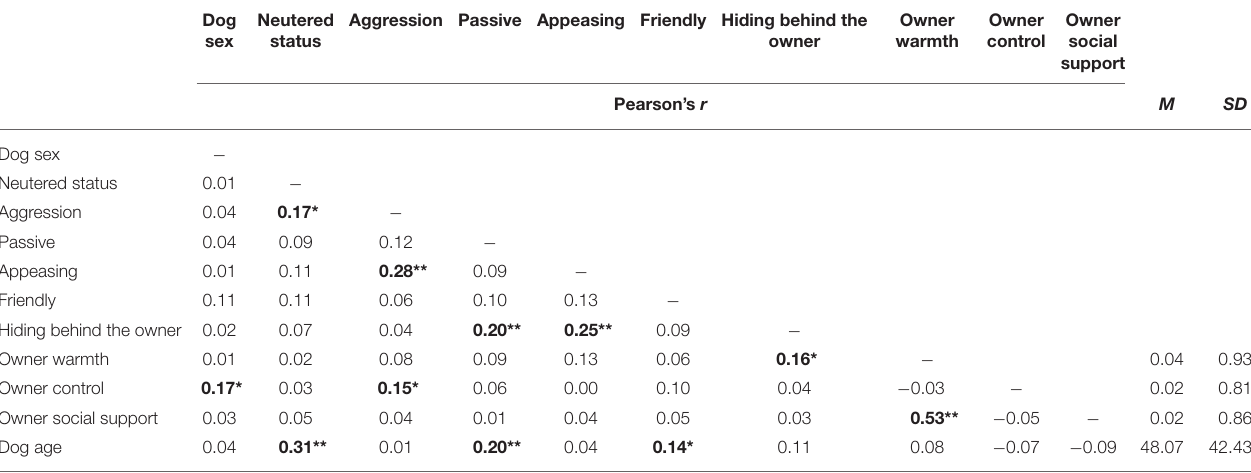
TABLE 5 | Correlations between Owner interaction styles, dog demographic characteristics, dog behavior during the Threatening approach test (Pearson’s r and descriptive